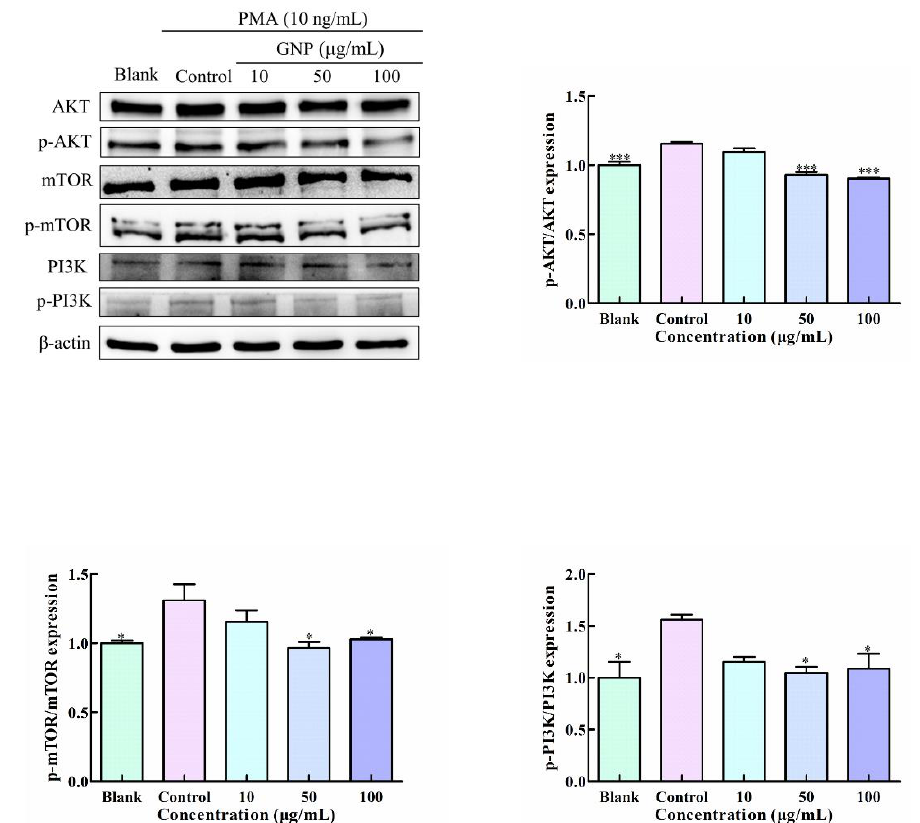
Figure 7. The protein level of PI3K/AKT/mTOR signaling pathway in HT1080 cells was determined by western blot analysis. β -actin was used as an internal control. Data are shown as mean ± SD ( n = 3). p < 0.05 (*), p < 0.001 (***) compared with PMA alone treated control group.